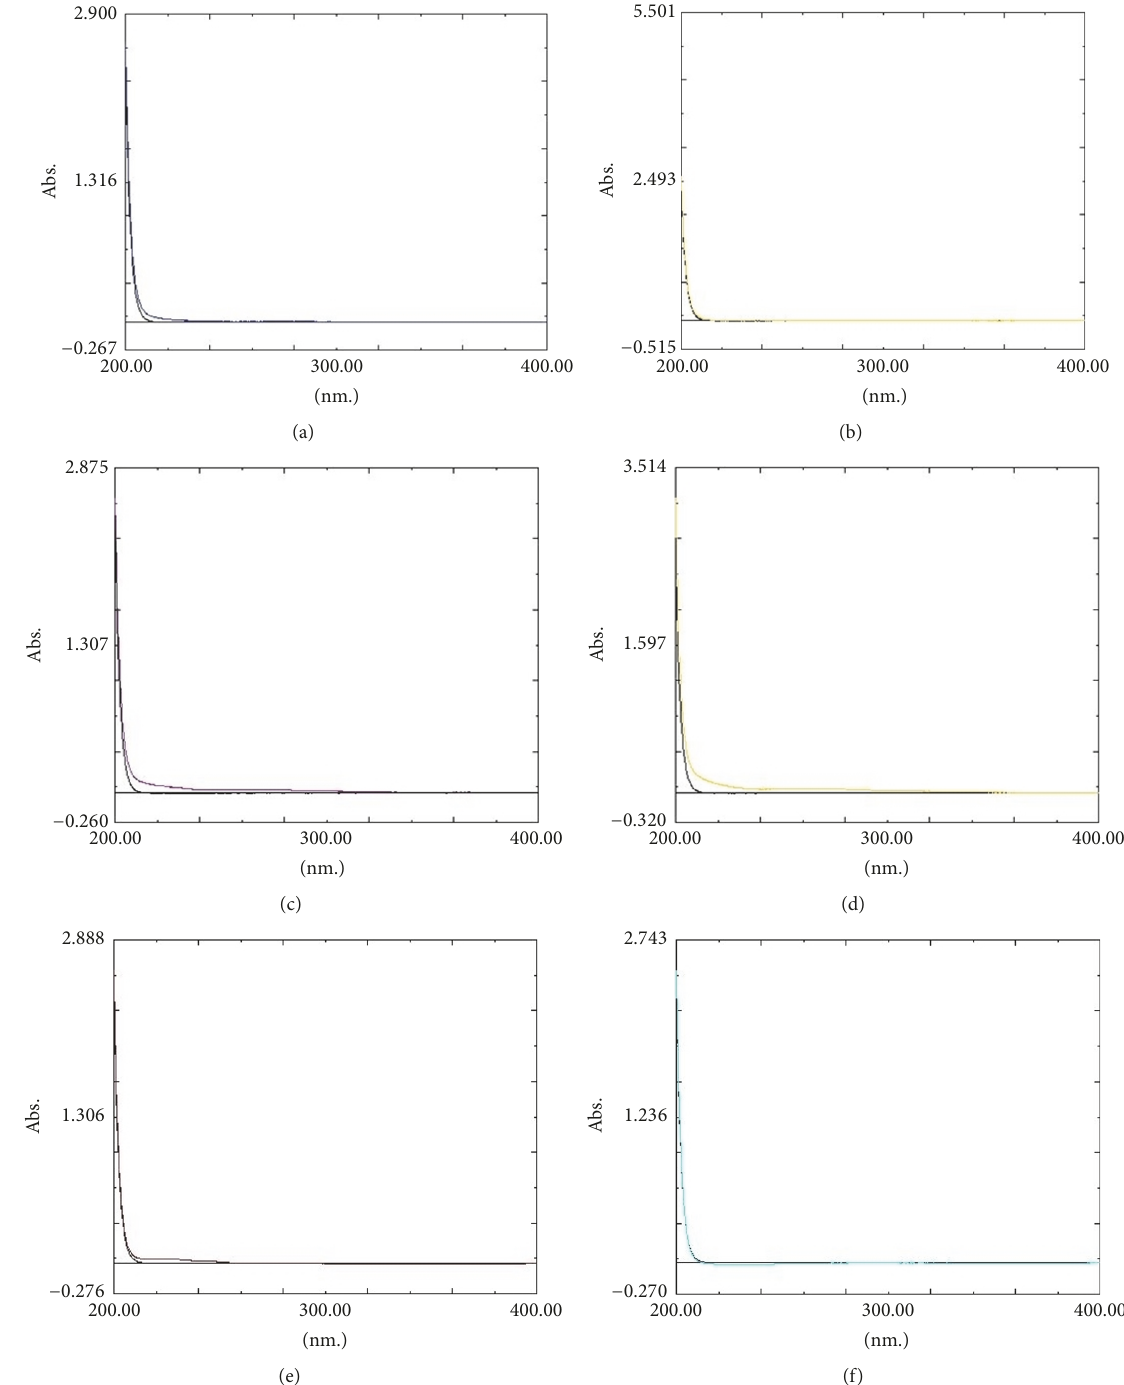
Figure 5: Dispersion characteristics compared with a pseudo-wound exudate: (a) hydrocolloid with a foam layer dressing, (b) hydrocolloid dressing, (c) calcium sodium alginate dressing, (d) calcium alginate dressing, (e) foam with a polyurethane film layer dressing, and (f) foam with a hydrogel and polyurethane film layer